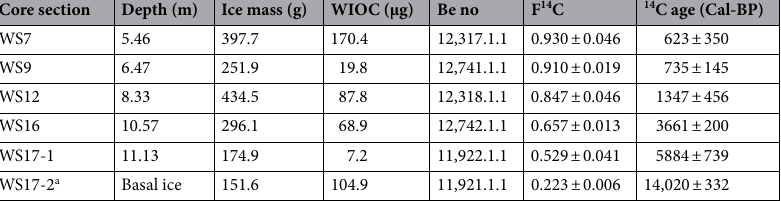
Core section Depth (m) Ice mass (g) WIOC (µg) Be